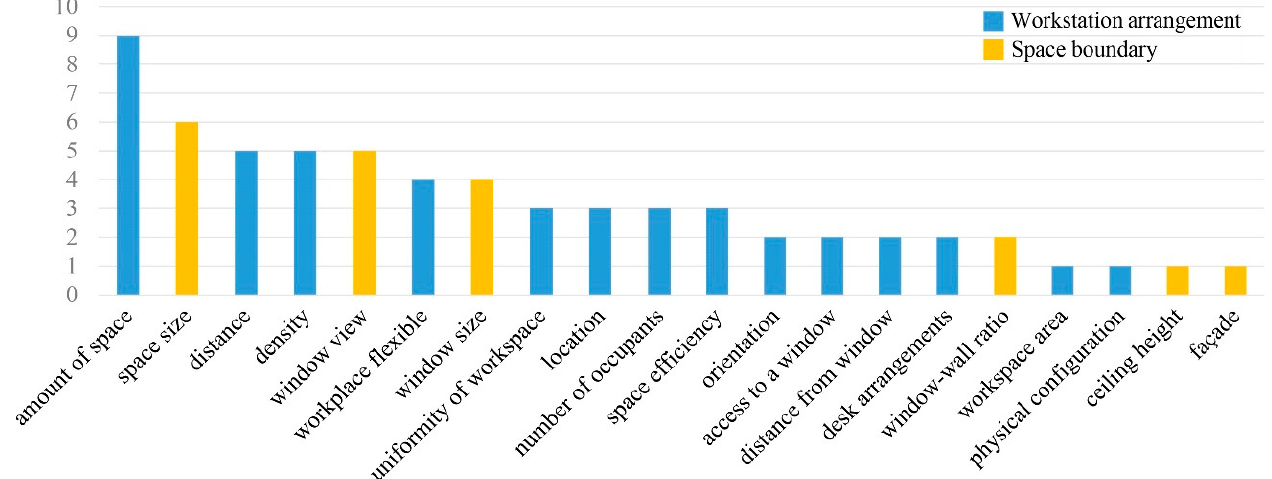
Figure 2. Office layout words in the literature abstracts.